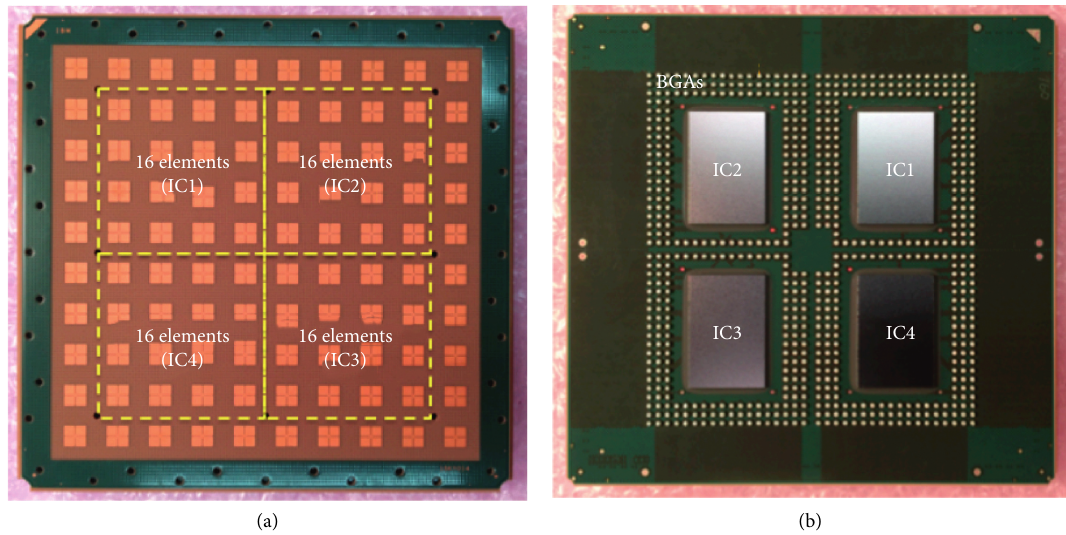
Figure 8: Top view (a) and bottom view (b) of the antenna module as presented in [62] ©2019 IEEE.